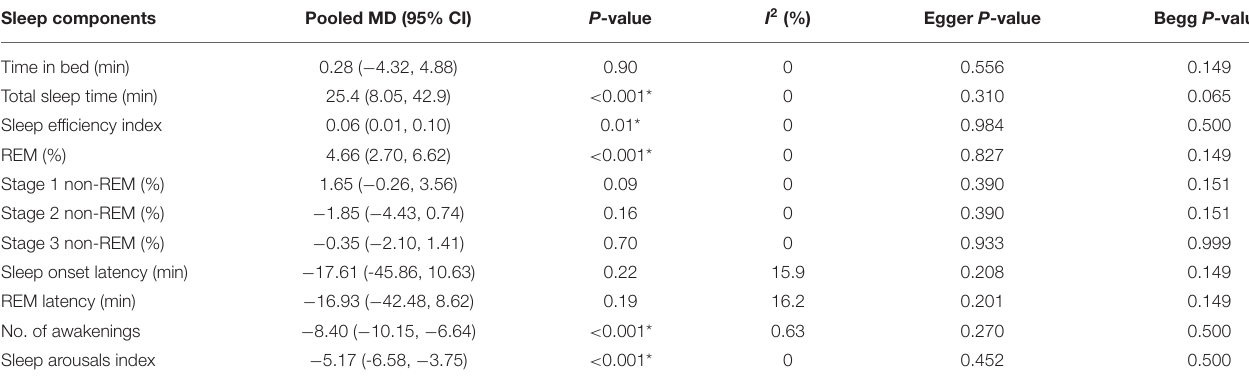
TABLE 4 | Efficacy of eye masks and/or earplugs interventions for sleep quality based on polysomnography. Sleep